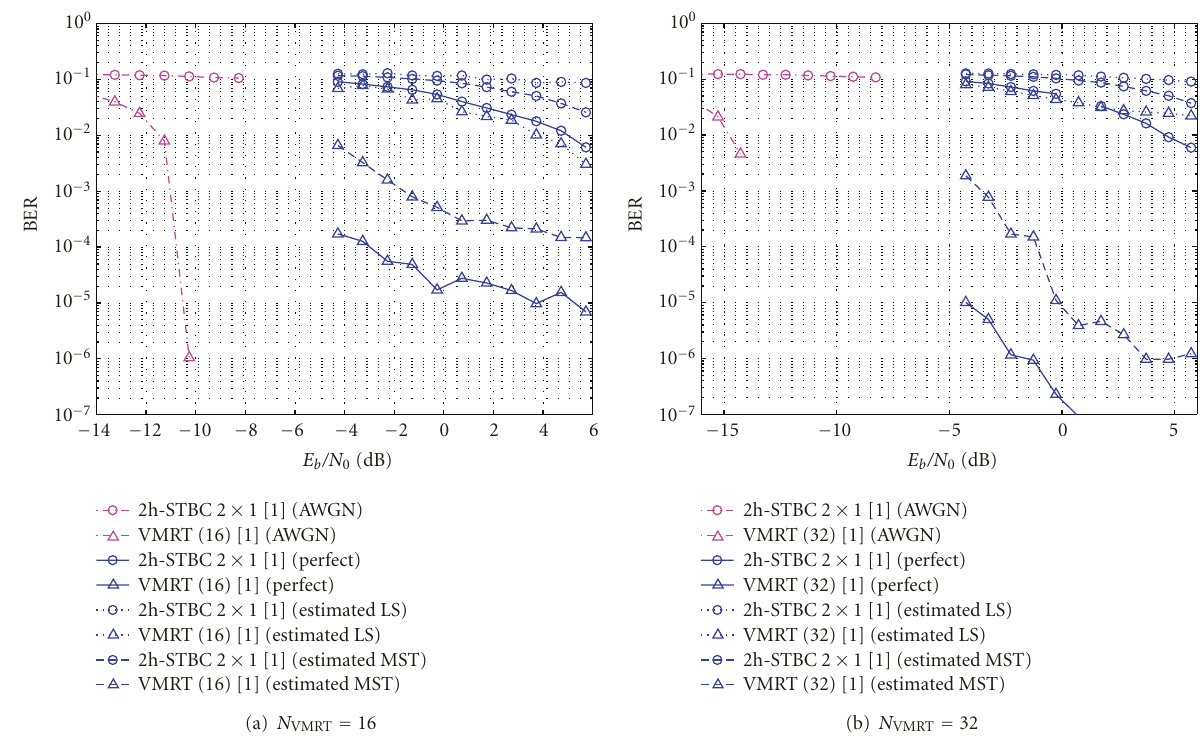
Figure 5: E ff ect of channel estimation: BPSK with LDPC codes, SUI-3 channel; N t = 4, N RS = 8, N u = 4. Scenario